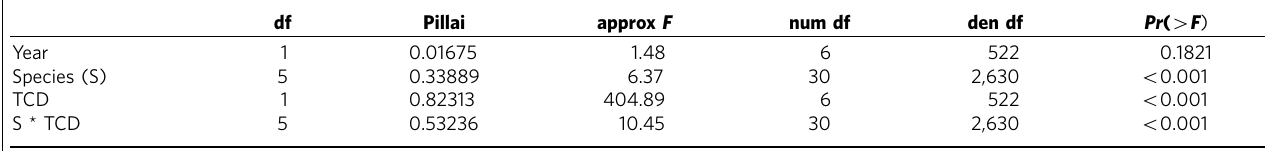
Table 3 | Temperature sensitivity of duration change for six individual phenological stages. df Pillai